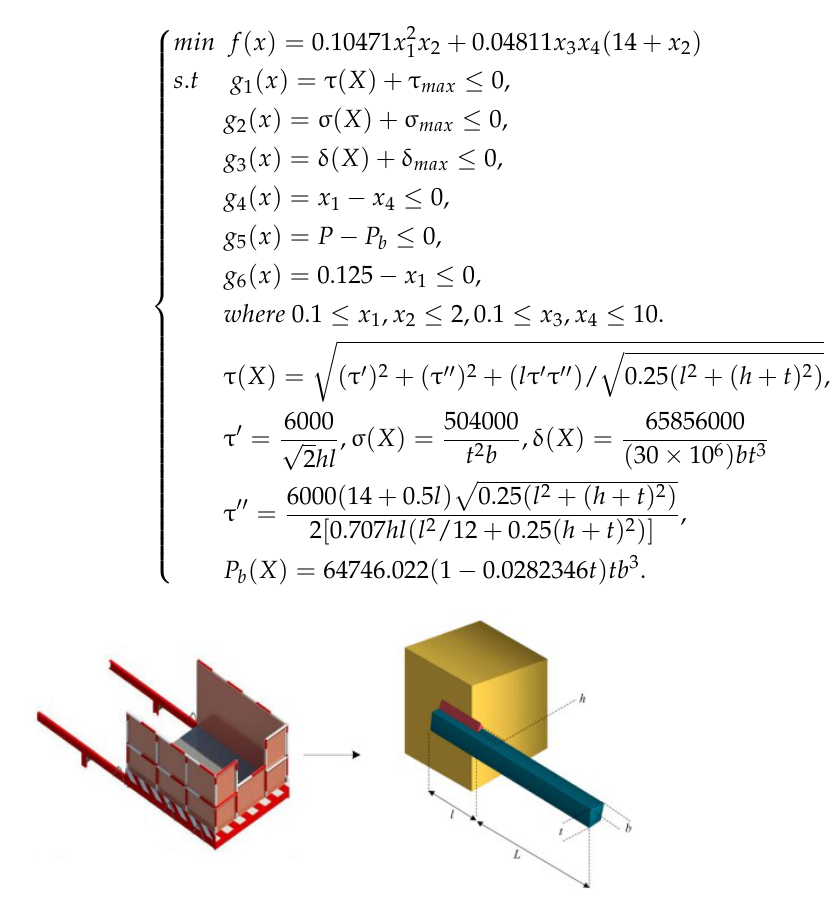
Figure 9. Design of welding